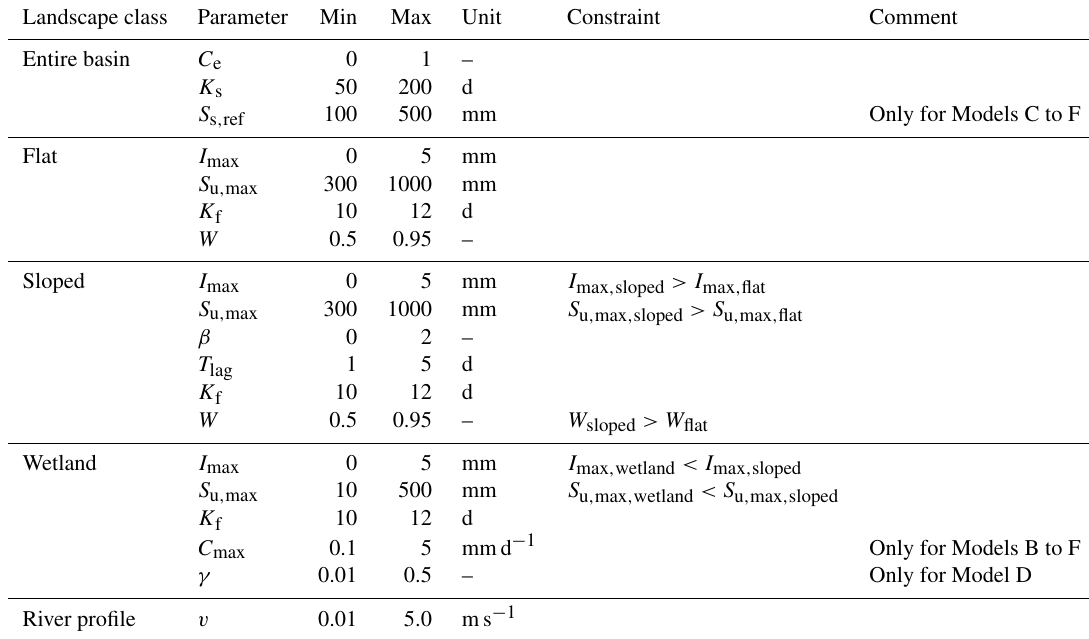
Table 3. Model parameter and ranges (Hulsman et al., 2020). Landscape class Parameter Unit